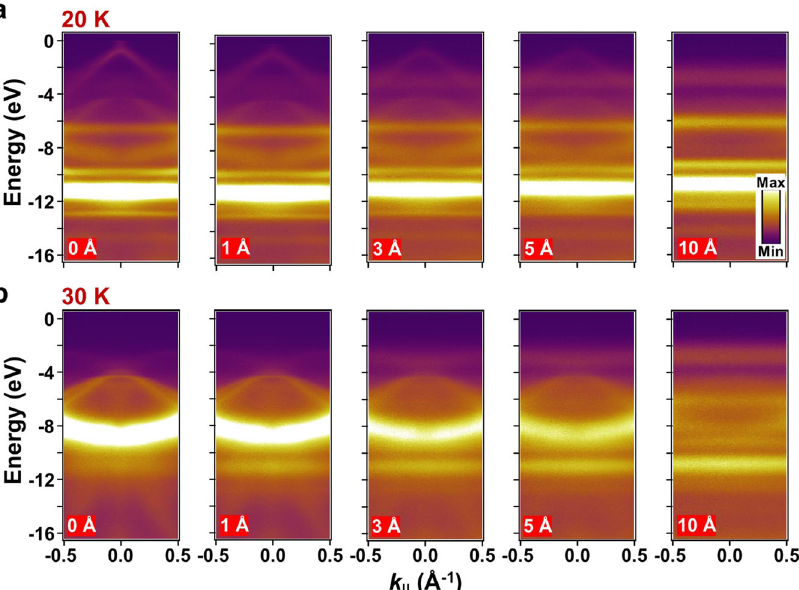
Fig. 3 Coverage-dependent ARPES maps upon forceful addition of Se. a ARPES maps taken with the sample maintained at 20 K. b ARPES maps taken with the sample maintained at 30 K.